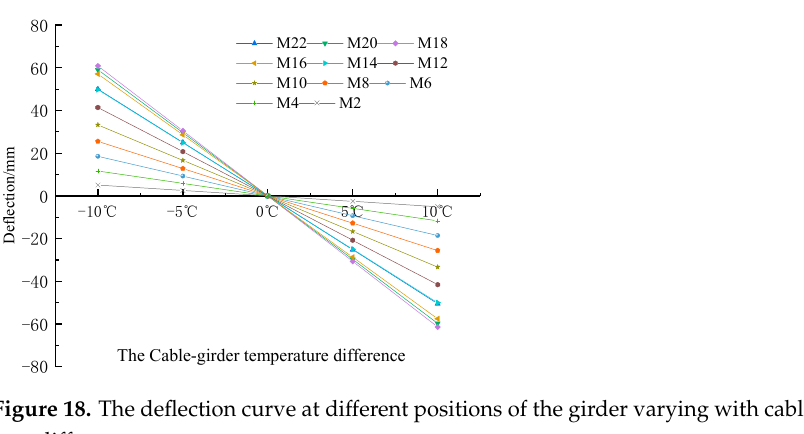
Figure 17. The distribution curve of the deflection of the girder under different cable–girder temperature difference in healthy state.